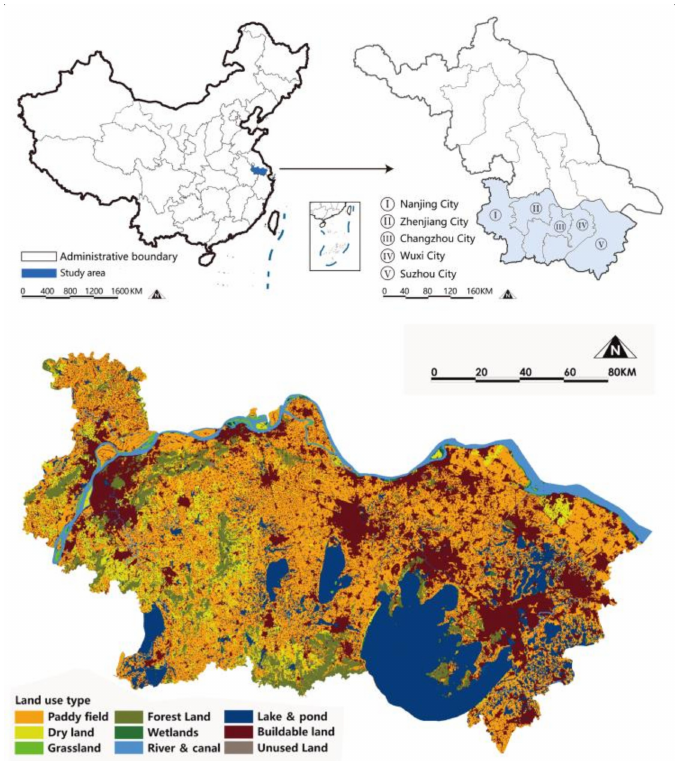
Figure 1. Location and land utilization status of the study